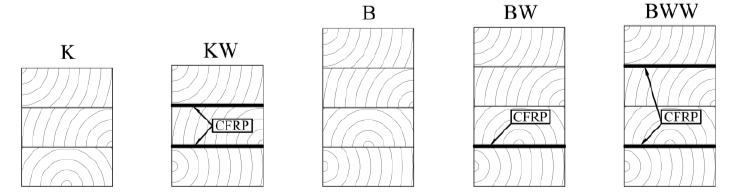
Figure 9. Wood–FRP girders configurations.